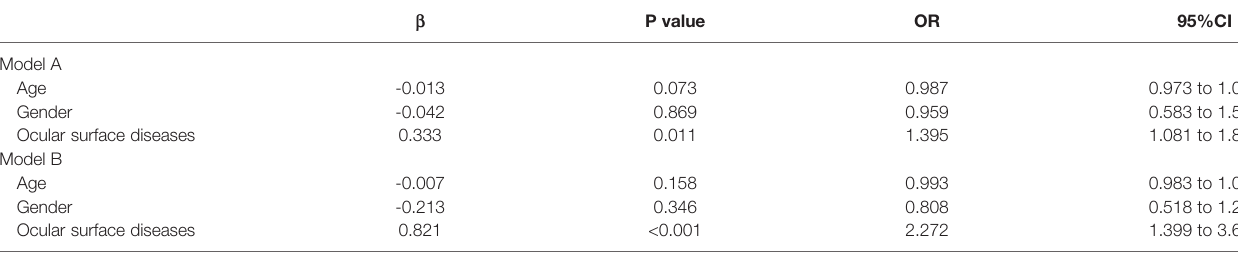
TABLE 5 | Associations between ocular surface diseases and risk of SARS-CoV-2 infection (IgG + ).